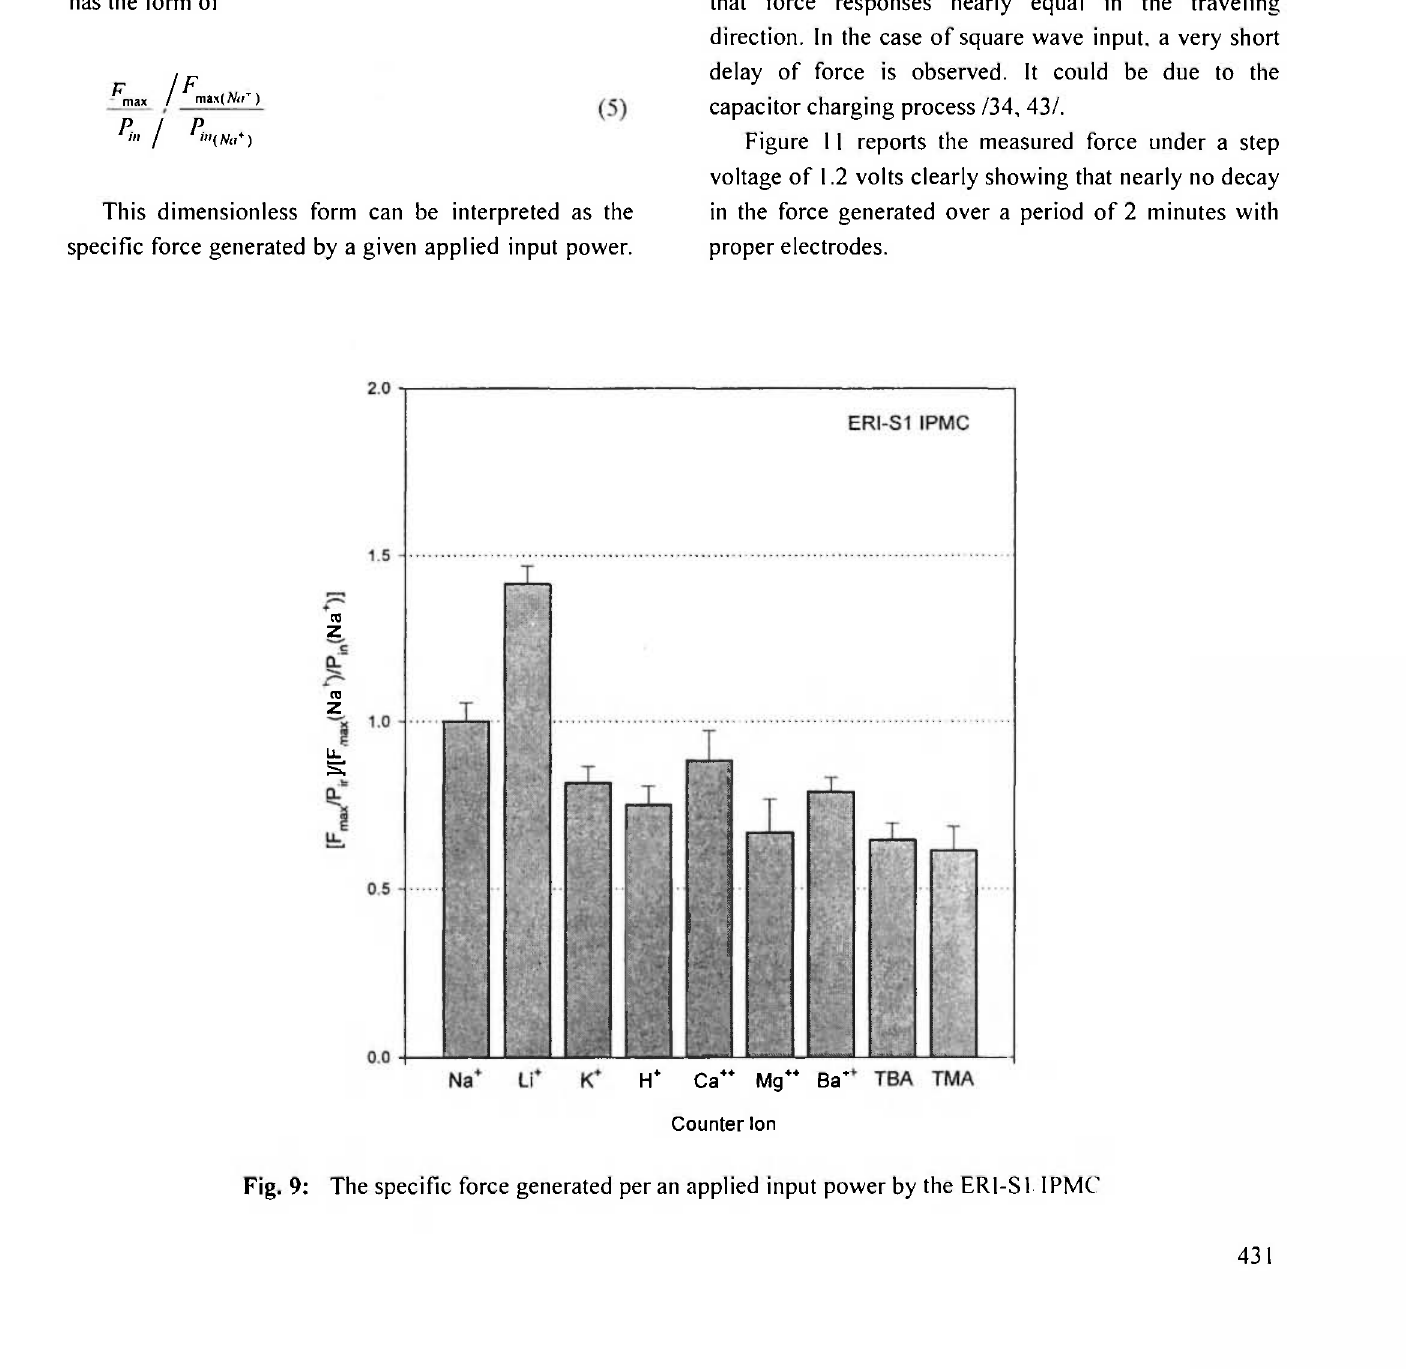
Fig. 9: The specific force generated per an applied input power by the ER1-S1